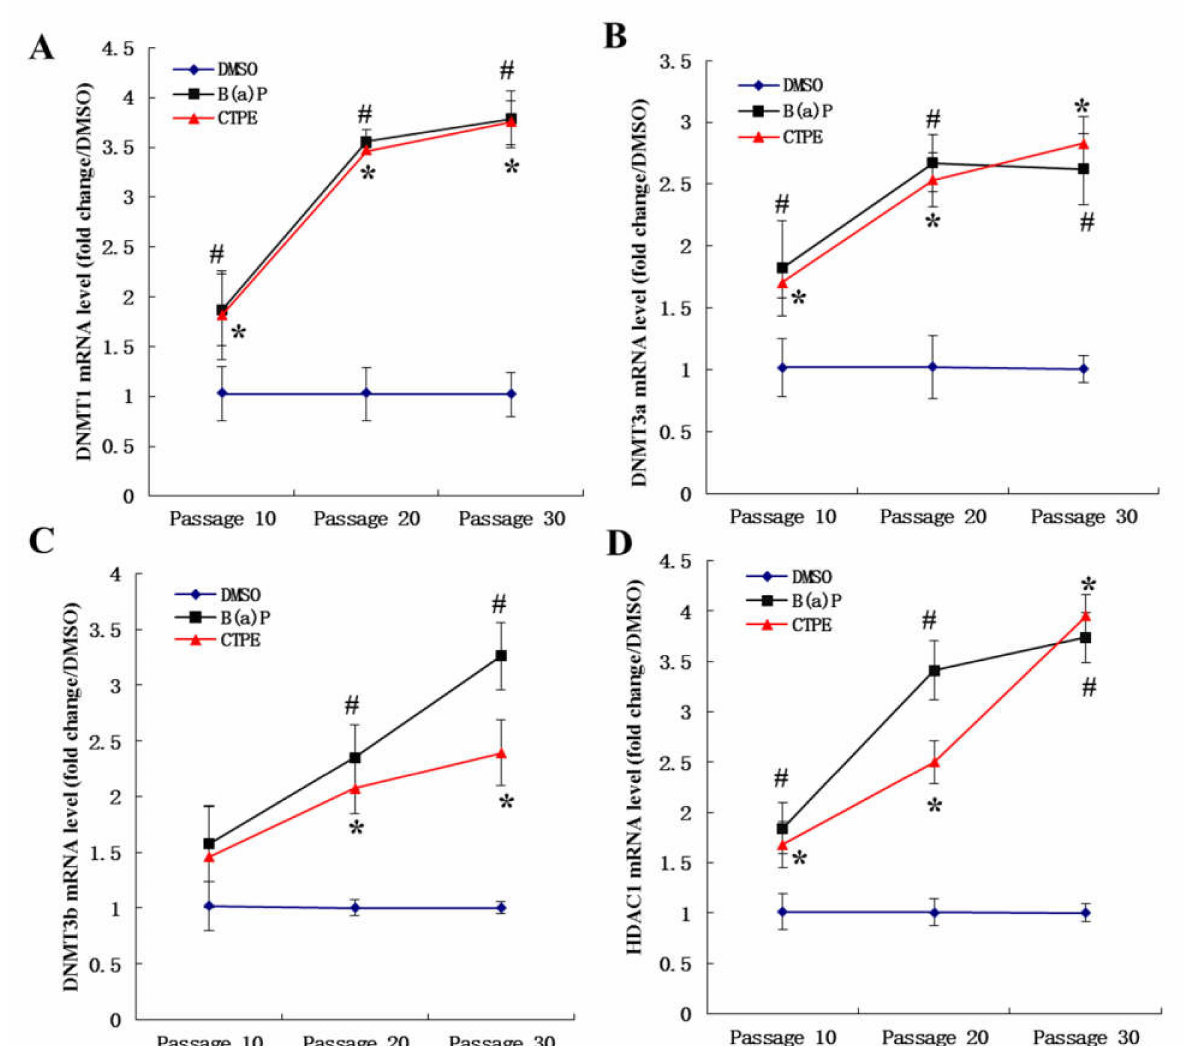
Figure 3. The mRNA levels of DNMT1, DNMT3a, DNMT3b, and HDAC1 of cells in the three groups. The mRNA levels of ( A ) DNMT1, ( B ) DNMT3a, ( C ) DNMT3b or ( D ) HDAC1 in DMSO, CTPE, and B(a)P groups at passage 10, 20 and 30. The results were presented as mean ± SD ( n = 3, *: CTPE vs. DMSO, p < 0.05. #: B(a)P vs. DMSO, p <